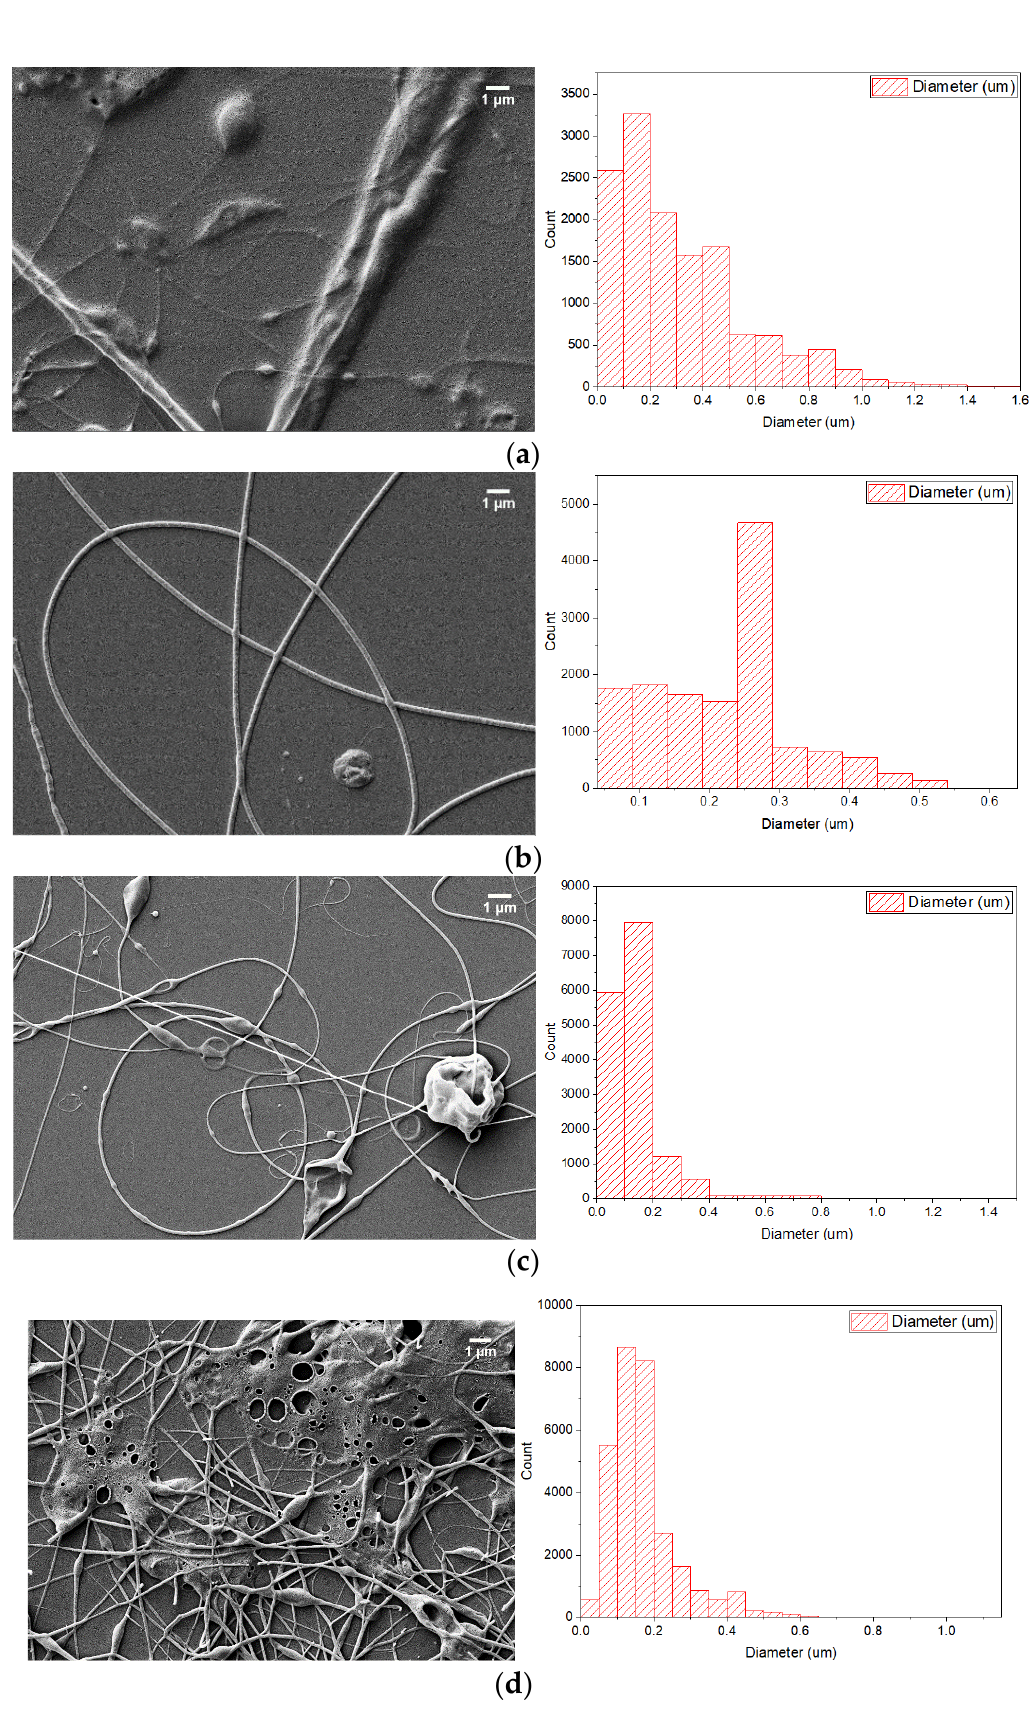
Figure 6. SEM figures of a) PT15 9%PCL 0.3-0.6ml/h, b) PT18 9%PCL 0.3-0.6ml/h, c) RT15 9%PCL 0.3-0.6ml/h, d) RT18 9%PCL 0.3-0.6ml/h